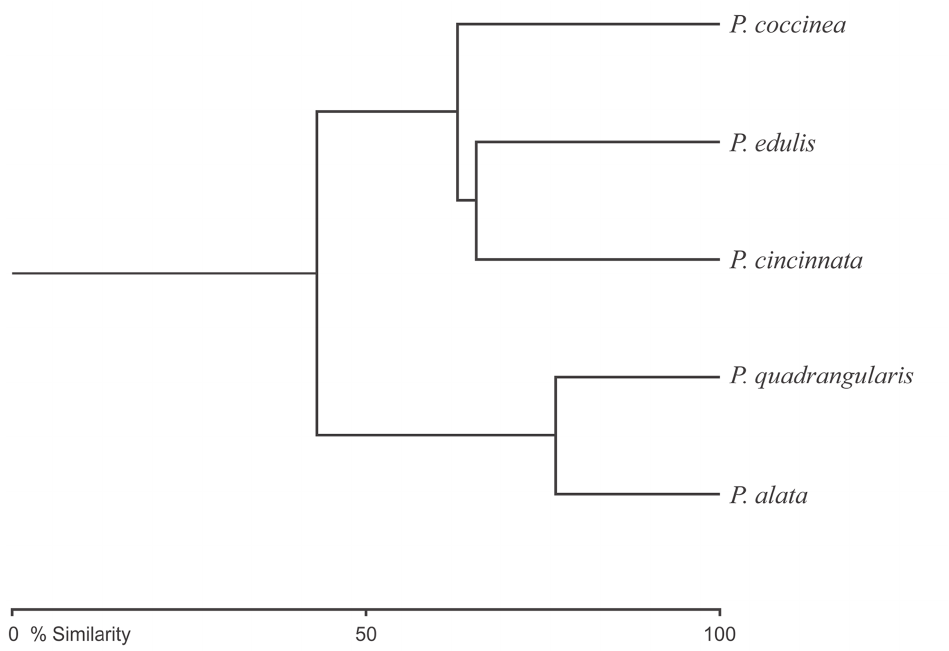
Figure 2 - Cluster analyze of similarity among floral scents of Passiflora species from Brazil.